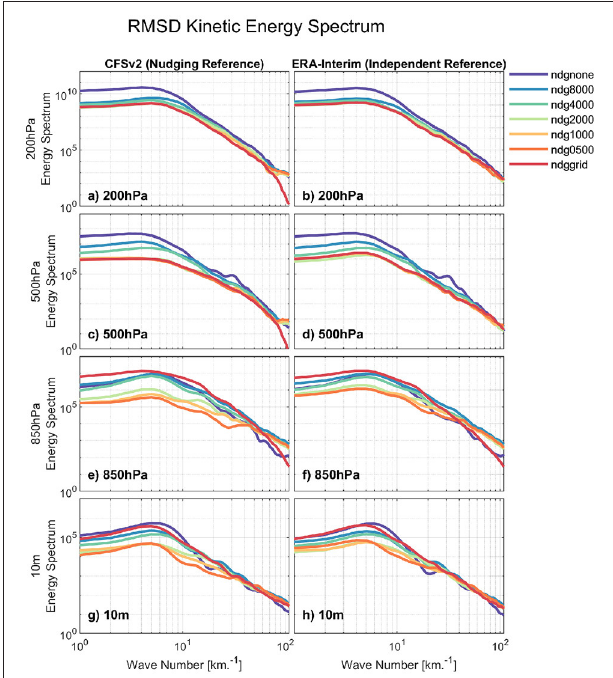
FIGURE 8 | Root Mean Square Deviation (RMSD) of the kinetic energy (in m 2 / s 2 ) calculated using the CFSv2 reanalysis (left) and the ERA-Interim reanalysis (right) for the SACZ case study. (a,b) Show top-level (200 hPa) results, (c,d) Show middle-level (500 hPa) results, (e,f) Show lower-level (850 hPa) results, (g,h) Show near-surface (10 m) results.